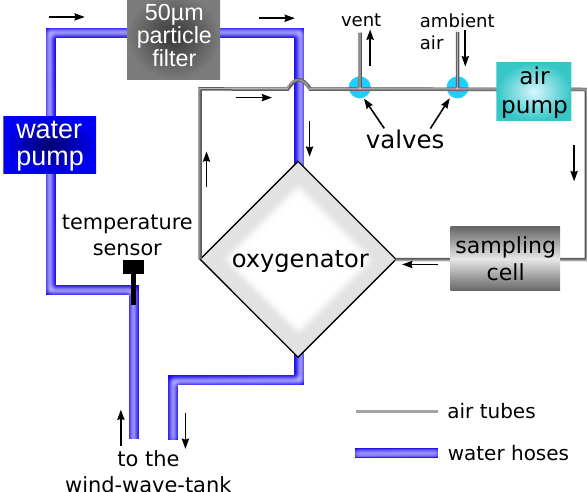
Fig. 3. Gas extraction setup. Water pumped from the wind-wave tank is equilibrated with air using an oxygenator. The air is contin- uously cycled between the oxygenator and the UV-spectroscopic measuring cell. The valves allow background sampling and are closed during